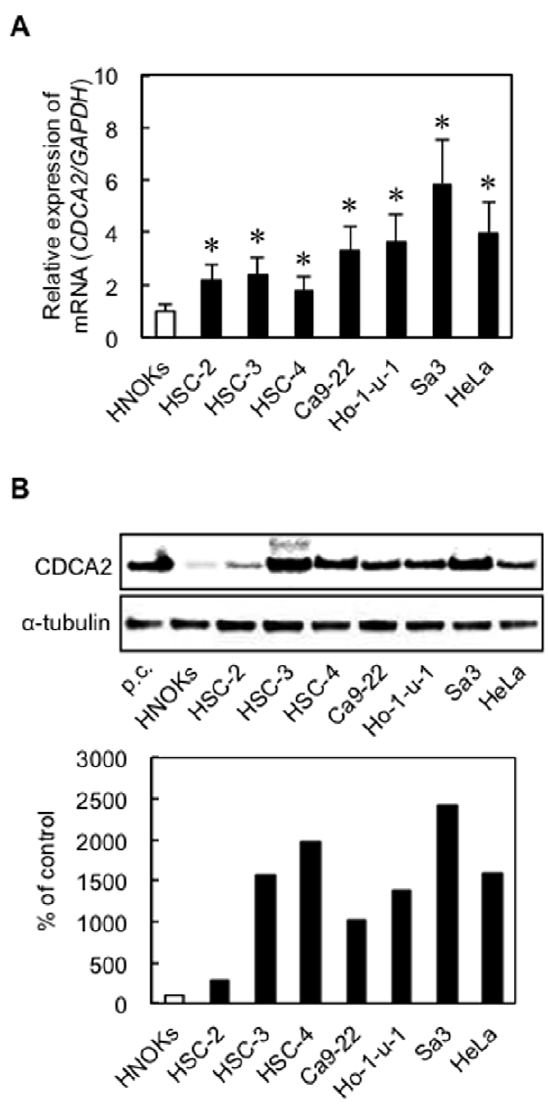
Figure 1. Evaluation of CDCA2 expression in OSCC-derived cell lines and the HeLa cell line. ( A ) Quantification of CDCA2 mRNA expression in OSCC-derived cell lines and the HeLa cell line by qRT-PCR analysis. Significant up-regulation of CDCA2 mRNA is seen in all cell lines compared with that in HNOKs (* P , 0.05, Mann-Whitney’s U test). Data are expressed as the means 6 SEM of triplicate results. ( B ) Western blot analysis of CDCA2 in the OSCC cell lines, the HeLa cell line, and the HNOKs. CDCA2 protein expression is up-regulated in all cell lines compared with HNOKs. Densitometric CDCA2 protein data are normalized to a -tubulin protein levels. The values are expressed as a percentage of the HNOKs. p.c., positive control (HepG2 (Human hepatocellular liver carcinoma cell line) Nuclear Lysate).